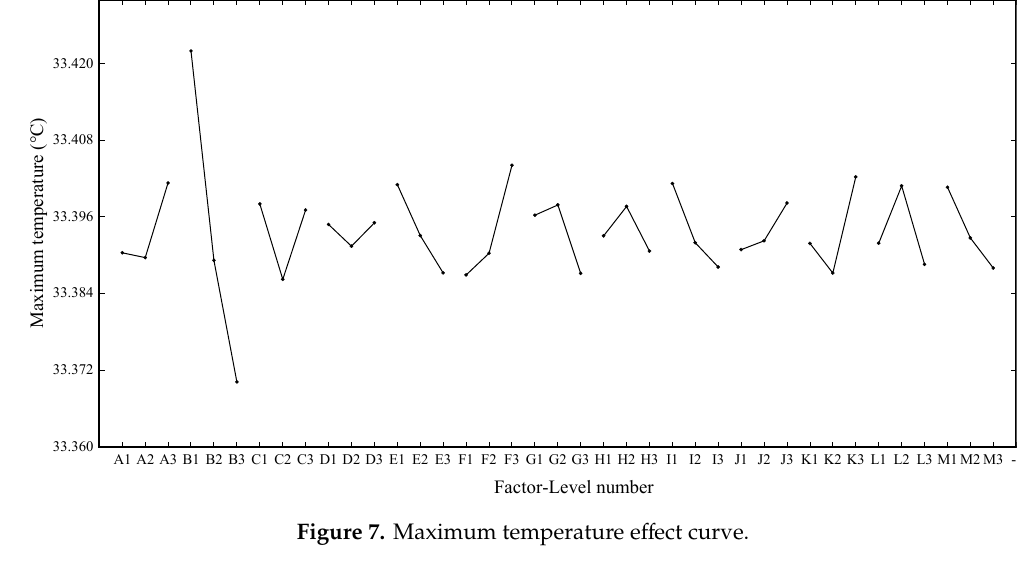
Figure 7. Maximum temperature effect curve.